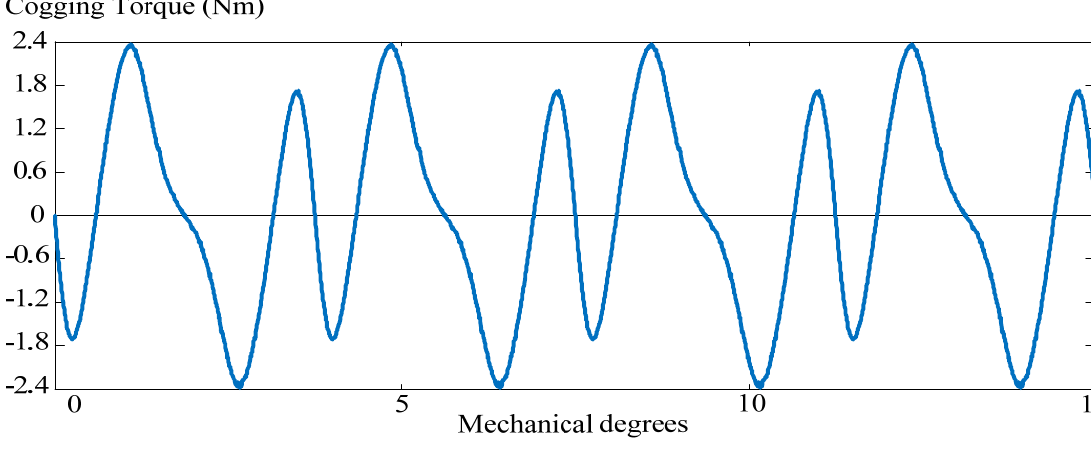
Figure 8. Typical cogging torque of HMPP of 100-pole, 96-slot machine.